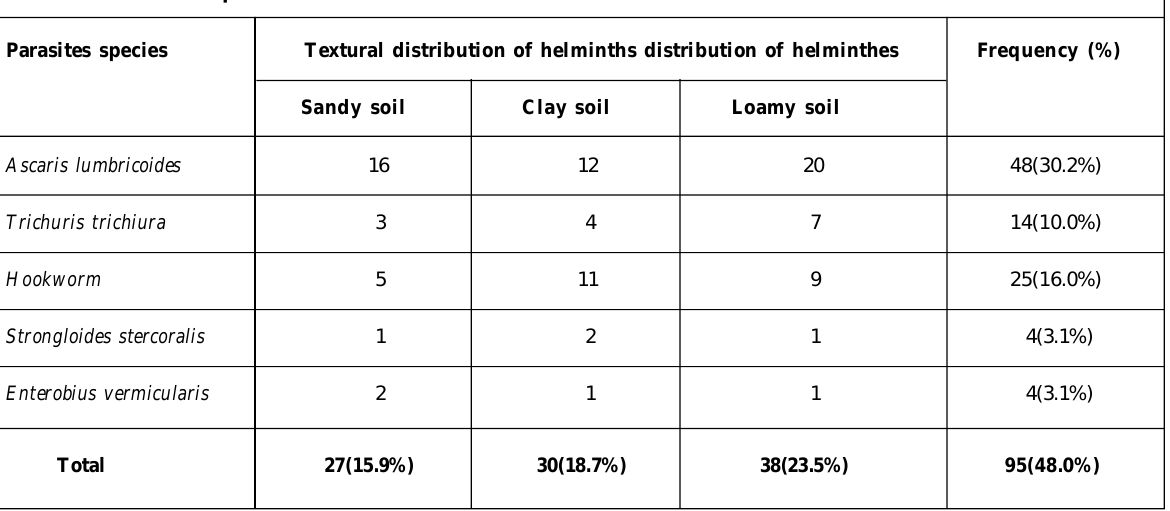
Table 2: Helminthes parasite distribution based on soil texture Parasites species Textural distribution of helminths distribution of helminthes Sandy soil Clay